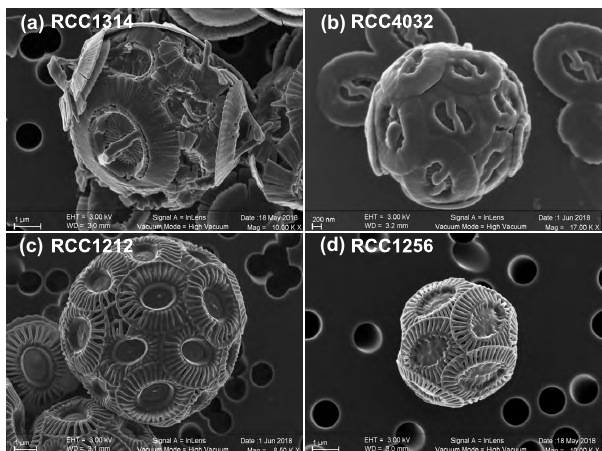
Figure 1. Scanning electron micrographs of the four strains of coc- colithophores (Haptophyta) cultured in the present study. Key to strain ID: RCC1314 is Gephyrocapsa oceanica (a) , RCC4032 is Gephyrocapsa ericsonii (b) ; RCC1212 is Emiliania huxleyi Mor- photype B (c) ; and RCC1256 is Emiliania huxleyi Morphotype A (bottom right). Note the higher magnification for the smallest cells studied, namely RCC4032 (d)